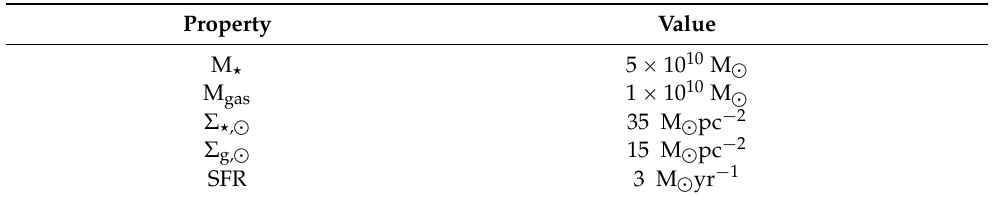
Table 4. Present-day Milky Way properties reproduced by the model: total mass in stars, total mass in gas, stellar surface density at the solar radius, gas surface density at the solar radius, and global star formation rate.